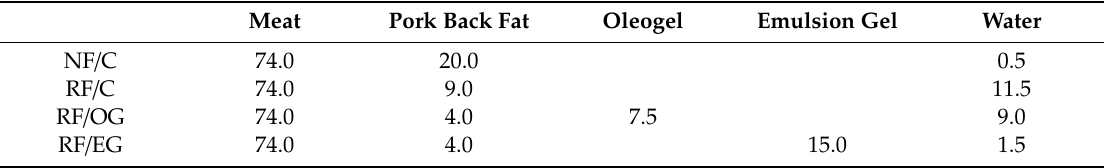
Table 1. Formulation (g / 100 g) of di ff erent